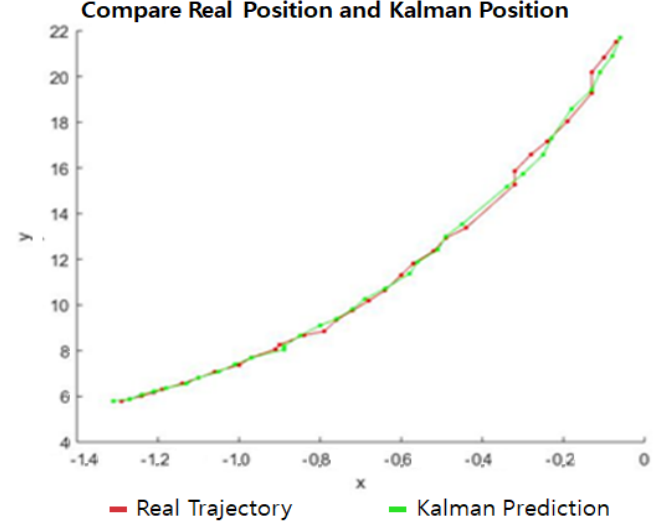
Figure 7. ( a ) The distance between curling stone and lidar. ( b ) Curling stone tracking using an algorithm.